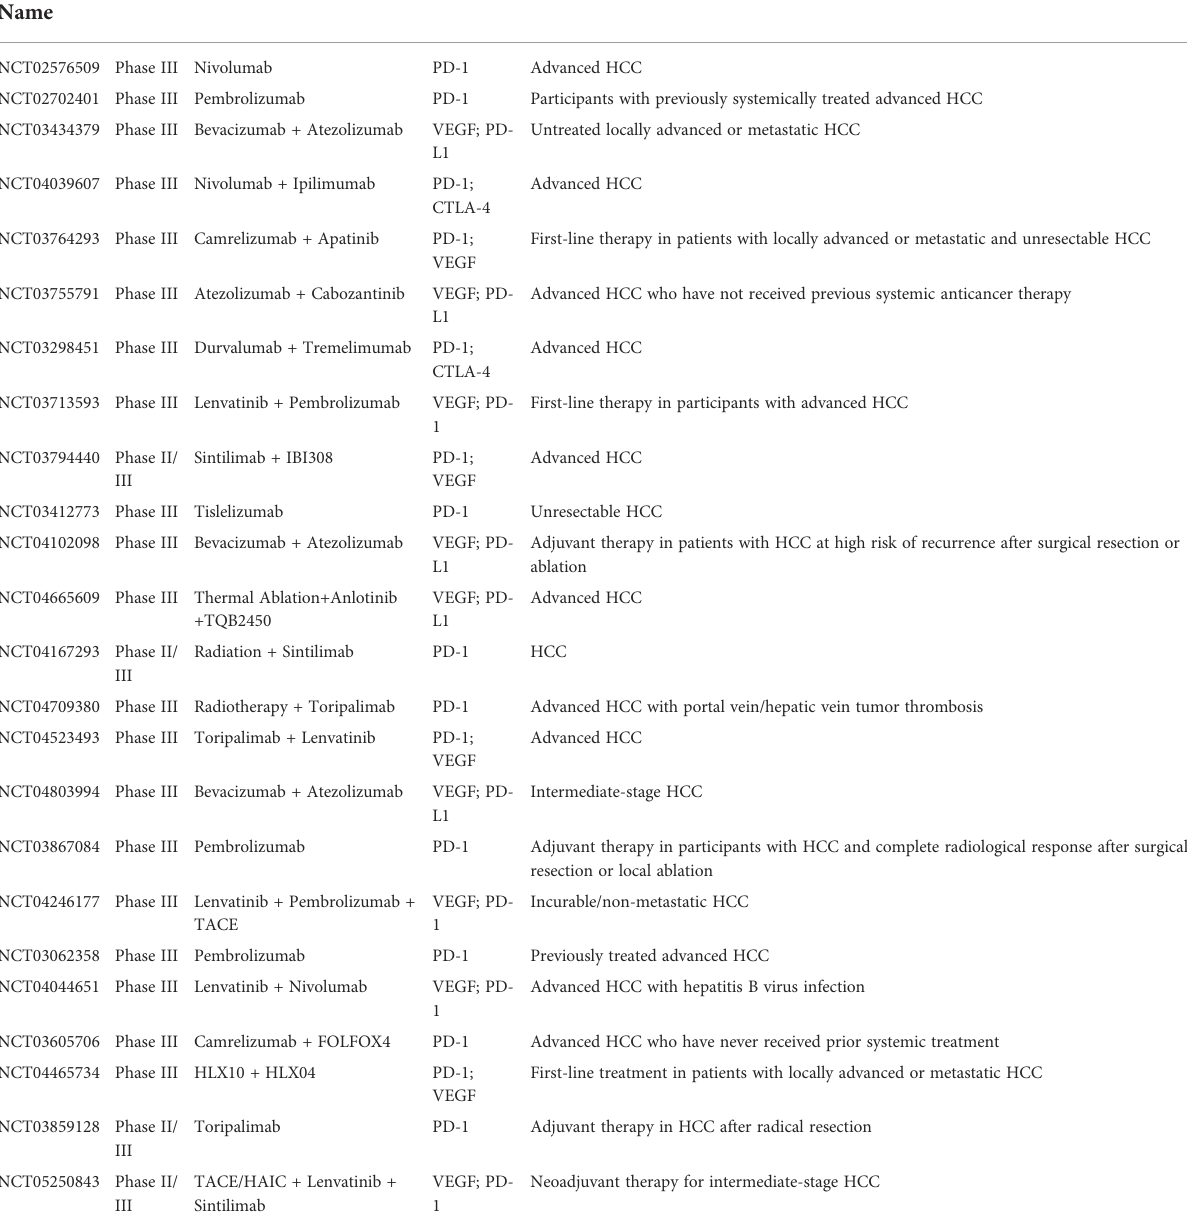
TABLE 1 Selected trials of immune checkpoint inhibitors in advanced hepatocellular